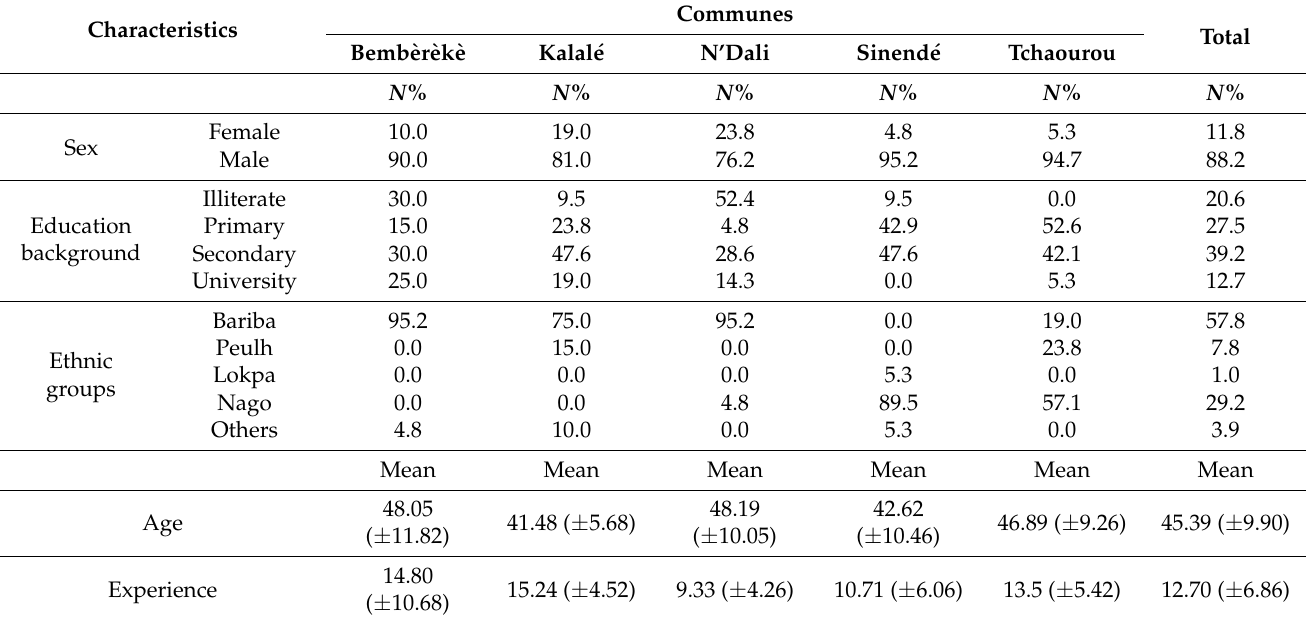
Table 3. Agricultural entrepreneur